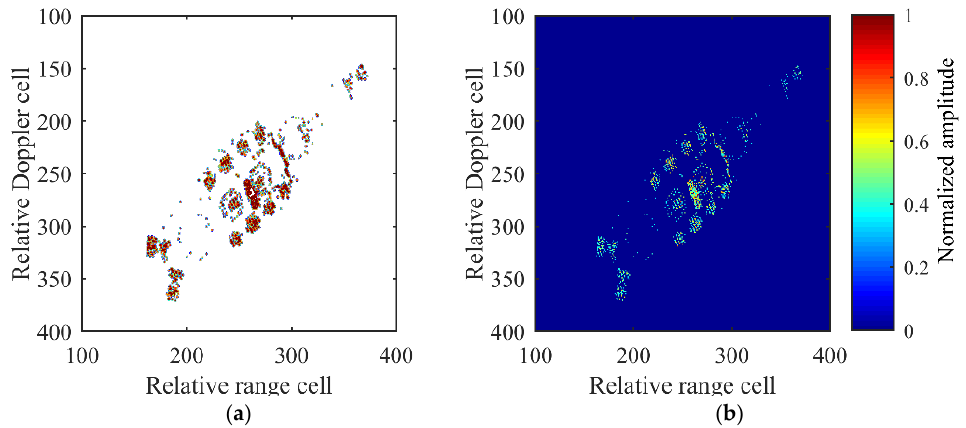
after which the detected interferograms are passed to the 3D reconstruction process.